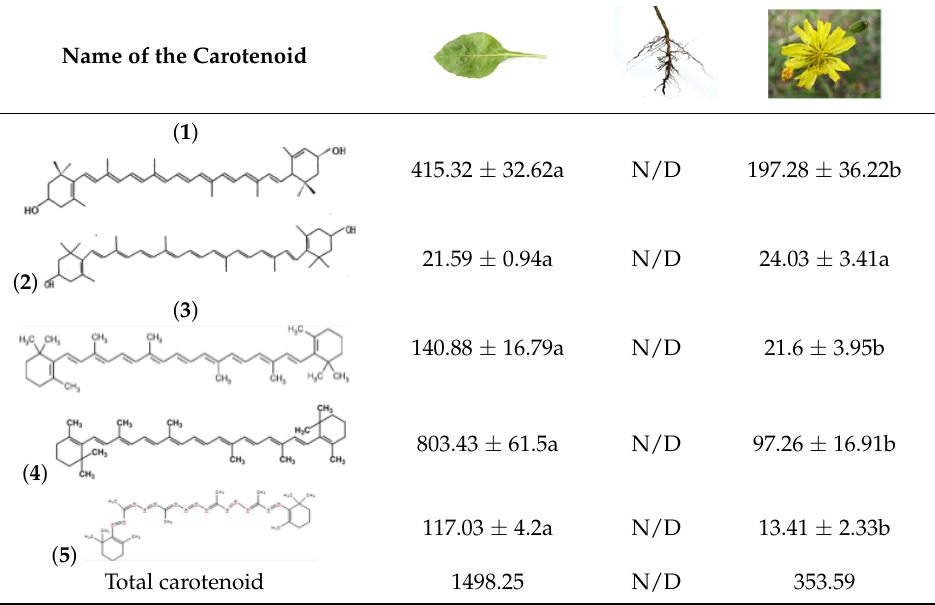
Table 1. Accumulation of carotenoids in different organs of I. dentata . Each value is the mean of three independent replications.